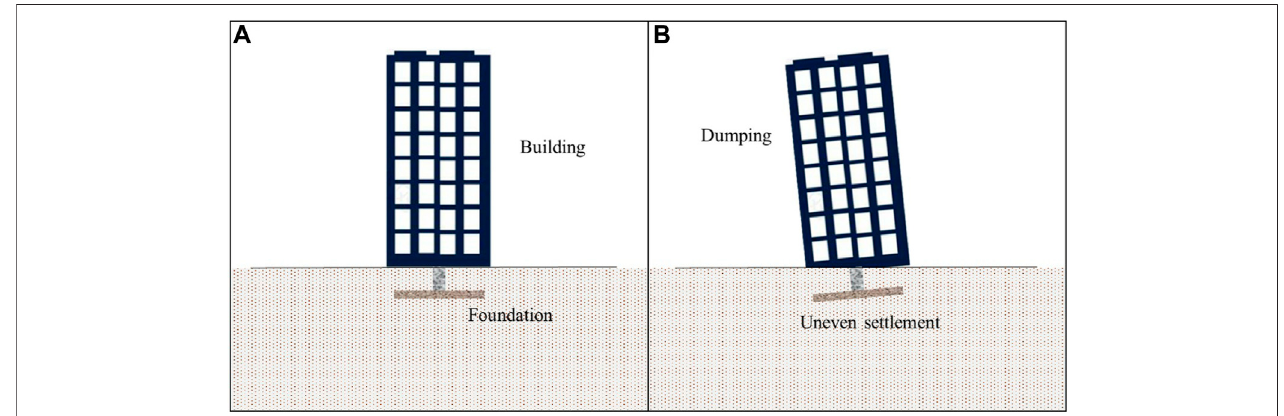
FIGURE 1 | Schematic diagram of building foundation settlement.